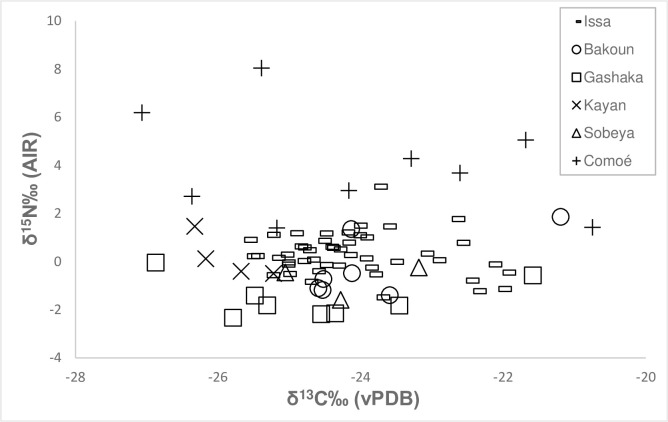
Scatter plot showing the variation in δ13C and δ15N values of Macrotermes samples across the six savanna woodland sites in this study.